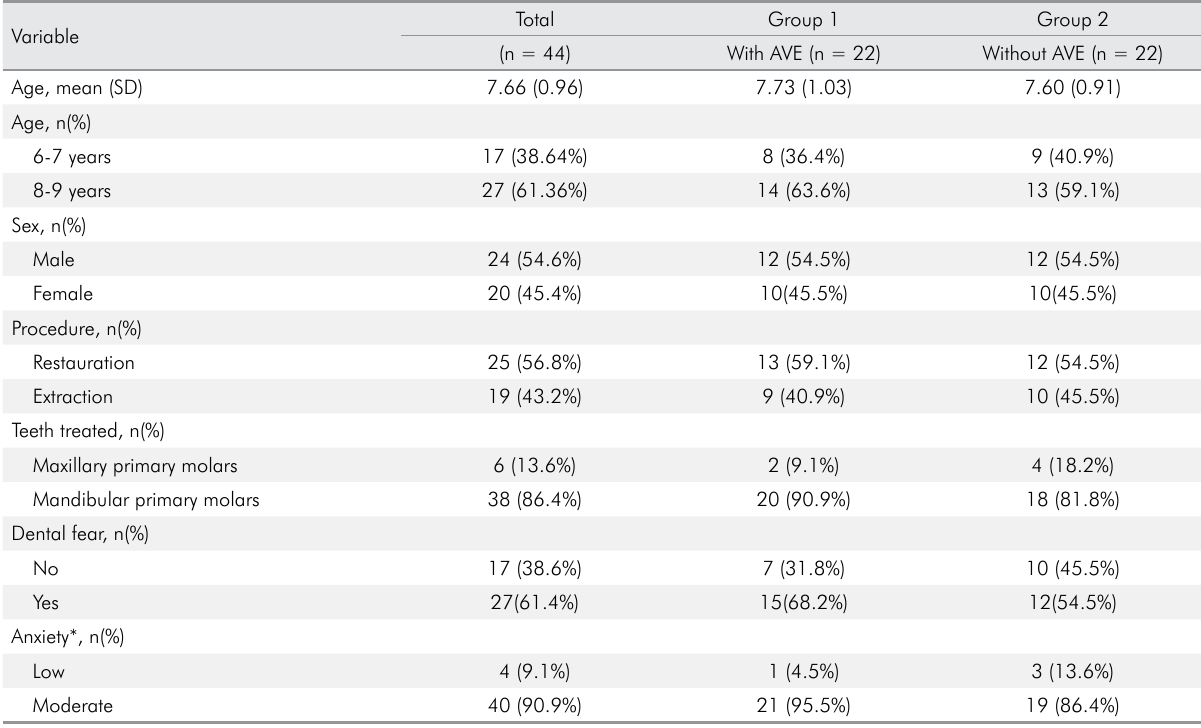
Table 1. Descriptive characteristics of groups according to the use of audiovisual eyeglasses (AVE) (n = 44).